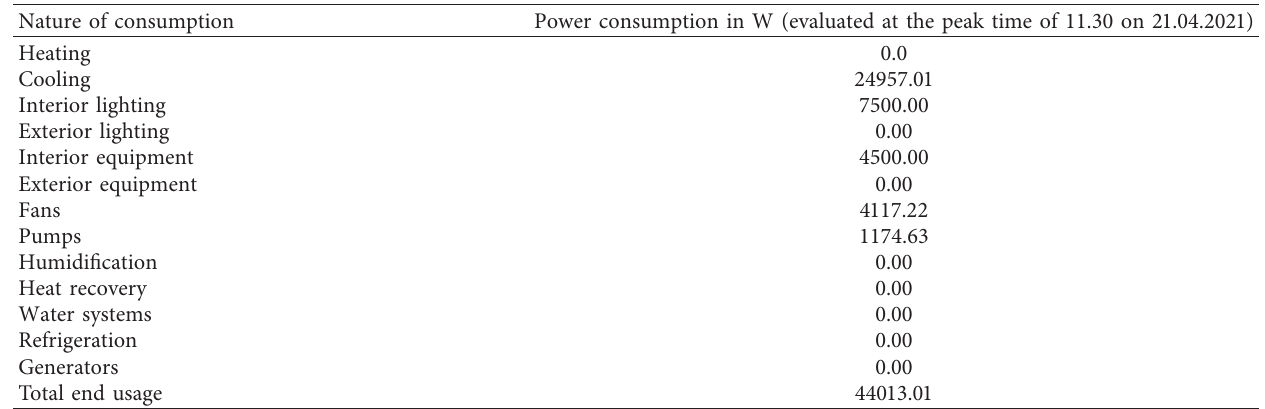
Table 2: Details of power consumption by various loads in a day.